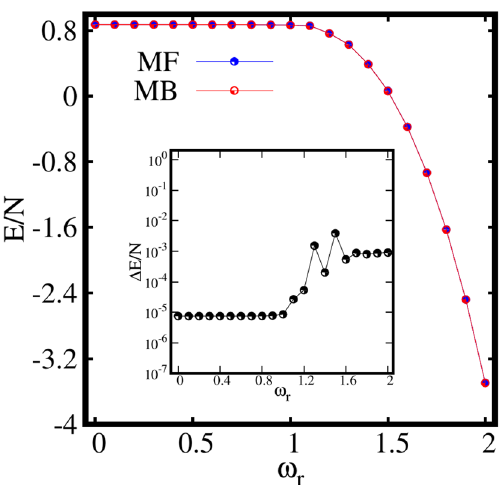
Figure 1. Behaviour of the ground state energy per particle E/N as a function of the rotation frequency ω r in an elongated trap computed at the mean-field (MF) and many-body (MB) levels (with M=1 and M=4 self- consistent orbitals, respectively). The inset shows the energy difference between the mean-field and many-body energies. All quantities shown are